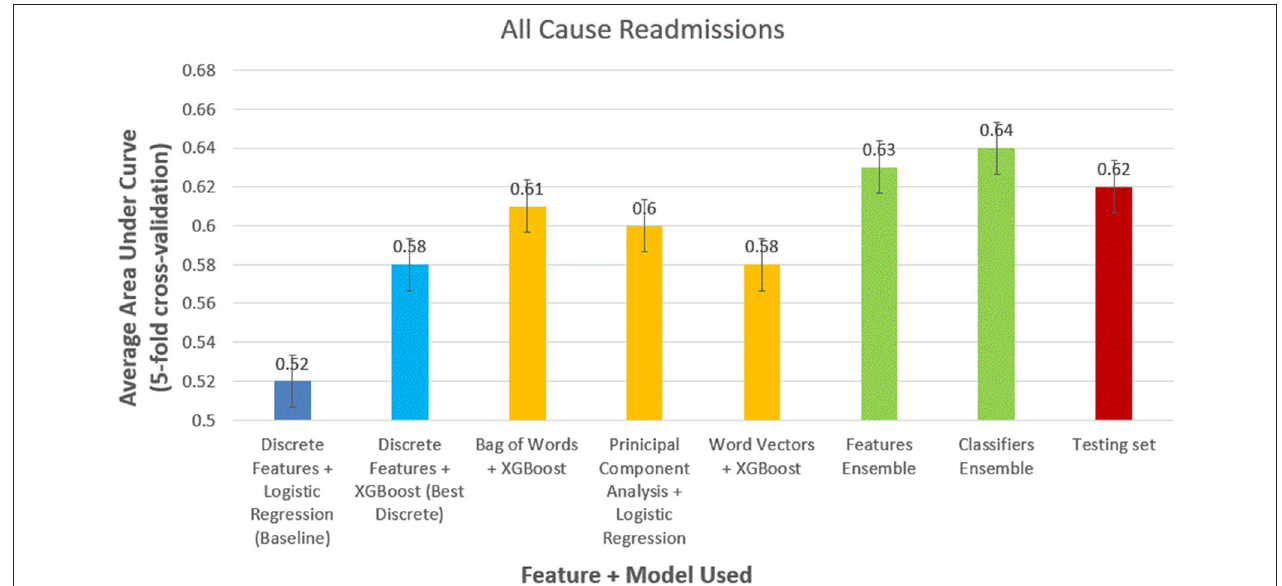
FIGURE 3 | Comparison of models to predict 30-day all-cause